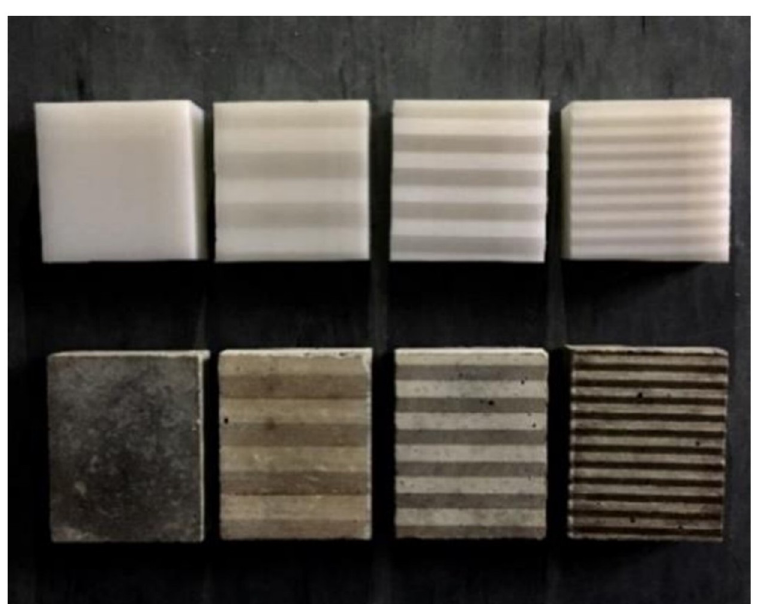
Fig 6. Image of test samples with different joint profiles.